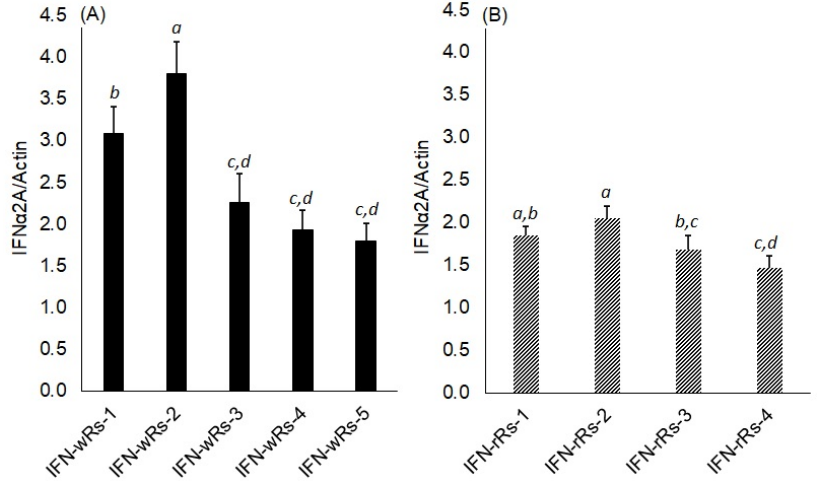
Figure 4. RT-PCR analysis of IFN α 2a gene expression in transgenic white ( A ) and red ( B ) Raphanus sativus L. plants. IFN- α 2a mRNA transcripts was measured by real-time qRT-PCR and calculated in arbitrary units compared to a standard dilution series. IFN-wRs 1-5: samples from five independent IFN α 2a transgenic white Raphanus sativus L. plants, IFN-rRs 1-4: samples from four independent IFN α 2a transgenic red Raphanus sativus L. plants. Data are represented as the average of at least three independent measurements of RNA preparations ± SE. Different small letters represent significant differences; p = 0.05.